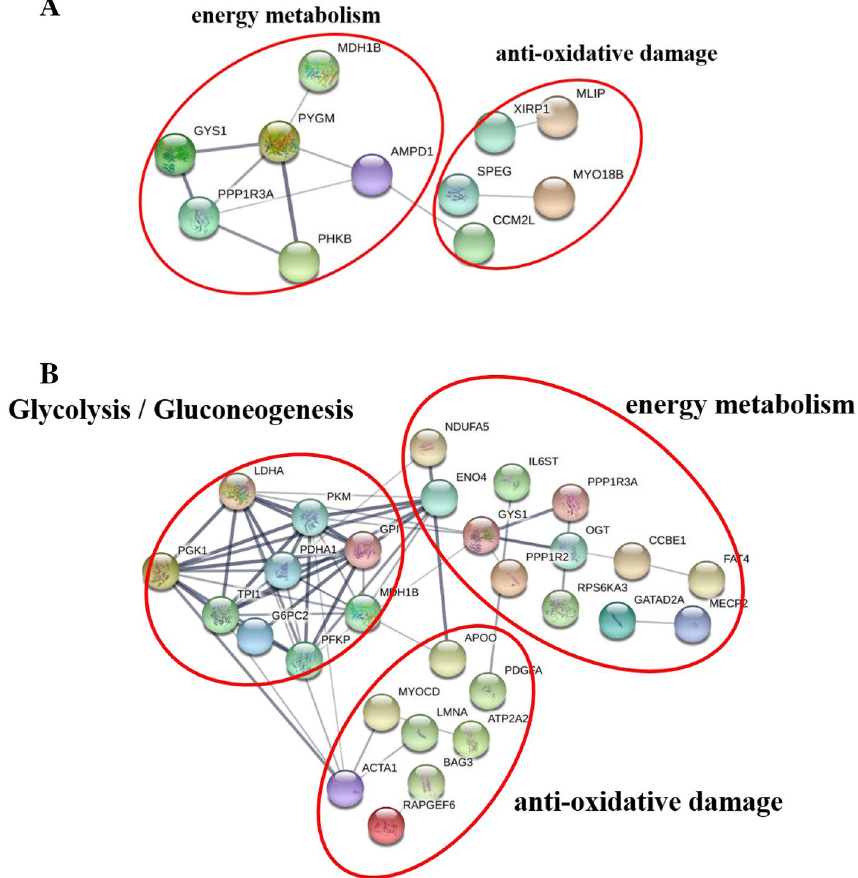
Figure 4. ( A ) A Protein–Protein Interaction Network Corresponding to the Comparison of Yushu and Gannan yak samples at 12 h. This network view summarizes the predicted associations for a particular group of proteins. The network nodes are proteins, while the edges represent predicted functional associations. Edges may be drawn with any of 7 differently colored lines corresponding to the seven types of evidence used in predicting these associations. A red line indicates the existence of fusion evidence; a green line—neighborhood evidence; a blue line – co-occurrence evidence; a purple line—experimental evidence; a yellow line—text mining evidence; a light blue line—database evidence; a black line—coexpression evidence. ( B ): A Protein–Protein Interaction Network Corresponding to the Comparison of Yushu and Gannan yak samples at 72